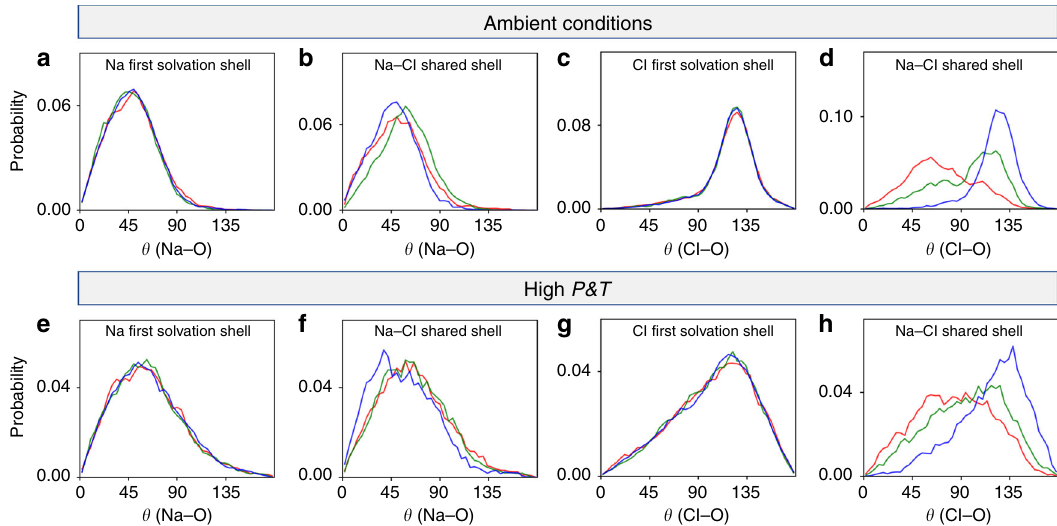
Fig. 1 Angular distribution functions at ambient and extreme conditions. Probability distributions of angles ( θ ) between Na – and Cl – O bonds and the dipole of water molecules belonging to the ion fi rst solvation shell ( a , c , e , g ), and the dipole of water molecules belonging to the shared Na – Cl shell ( b , d , f , h ), obtained with fi rst principles molecular dynamics simulations. a – d and e – h show the results for CIP (red line), TIS (transition state between CIP and SIP; green line) and SIP (blue line) at 400 K and 1 atm and 1000K and 11 GPa, respectively. The cutoff value used to de fi ne the fi rst solvation shell is 3.2 (3.9) Å for Na + (Cl − ) ion, chosen as the fi rst minima of the ion-O radial distribution function. Since we performed biased simulations (with an external force acting on the ions), we used a weighting scheme to recover unbiased statistics (see Supplementary Note 4).